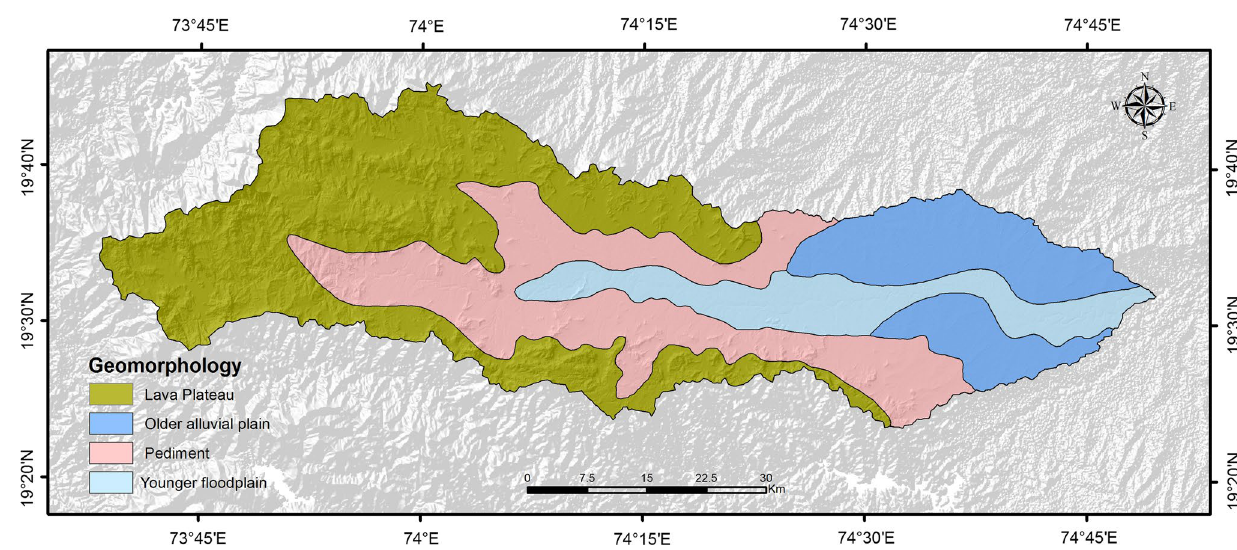
Fig. 5 Geomorphology map of the study